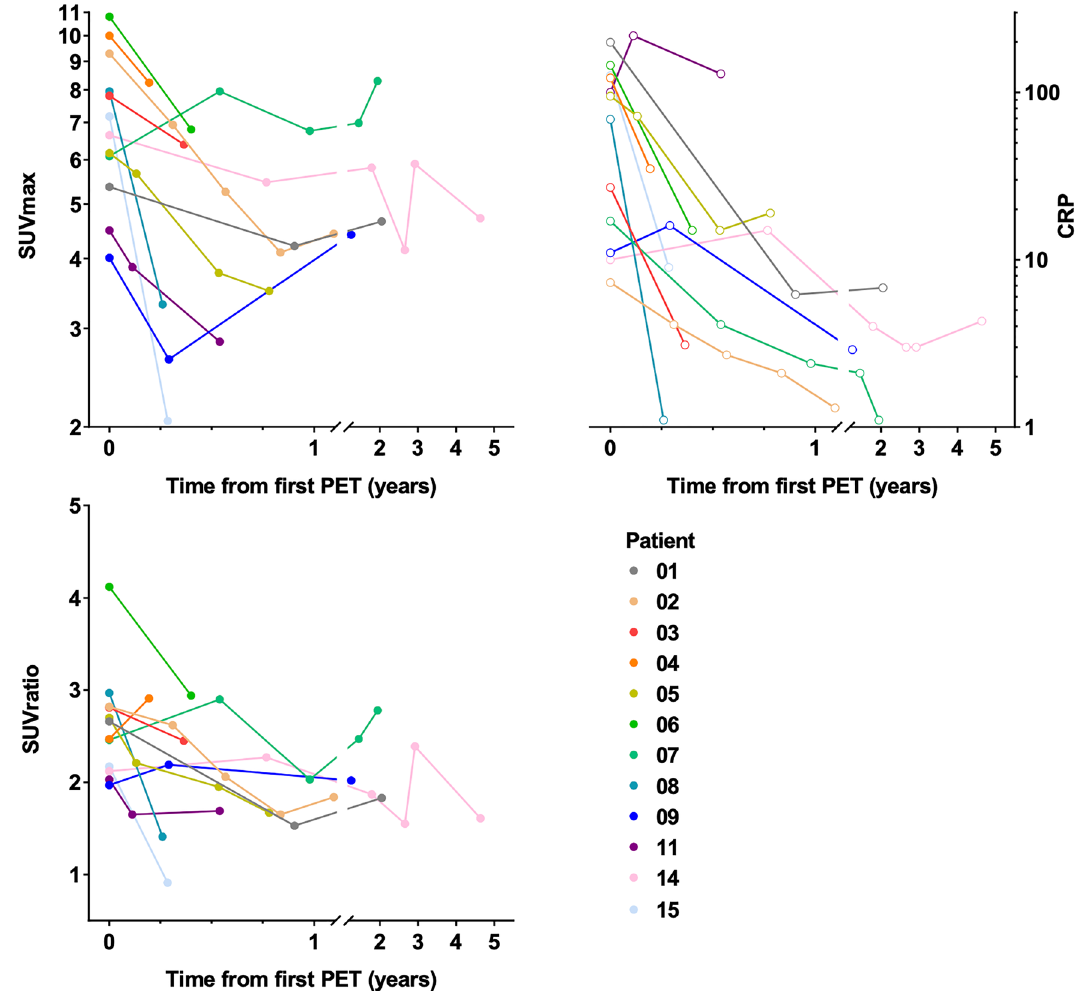
Figure 1. Courses over time of metabolic activity in PET/CT (SUVmax and SUVratio in the two graphs on the left) and CRP (graph on the right) in patients with proven infective native aortic aneurysms. Note : PET/CT provides additional or altering information (as defined in the methods section) on the course of disease in at least 14 comparisons (56%) in 11 patients (73%), as compared to CRP alone (i.e. patients: 02, 03, 04, 05, 06, 07, 08, 09, 11, 14, 15). Abbreviations: PET: positron emission tomography; SUV: standardized uptake value; CRP: C-reactive Thus, the final patient population consisted of 15 patients. All patients were eventually treated with open and/or endovascular repair (six prior to the first PET/CT, seven prior to the second, and two prior to the third PET/CT) (Table 1). At the time of the initial PET/CT examination, patients had a median age of 61 years (IQR 54–85), one patient (7%) was female, six (40%) were smokers or had a history of smoking, two (13%) patients were diabetic, and six (40%) had renal insufficiency. The diagnoses of INAA were confirmed by blood culture (n = 11; 73%), culture or PCR from tissue obtained during surgical revision (n = 2; 13%) and serology (n = 2, 13%) (Table 2). PET/CT examinations. We performed a total of 53 PET/CT scans in 15 patients (Figs. 1, 2, 3, Table 3) after intravenous injection of a median of 353 Megabecquerel of FDG (IQR 334—400). Initial imaging was per- formed for nine (60%) patients before and for six (40%) patients after vascular intervention, 11 (73%) received antimicrobial therapy at the time of initial imaging. The median visual 4-point grading score was 4 (11 × score 4, 3 × score 3, 1 × score 2). Eventually, all patients underwent vascular intervention with graft placement, and were treated with antibiotics (Tables 1 and 2). All aneurysms (or grafts) had increased focal FDG uptake on the initial PET/CT examination (SUVmax 6.8 (IQR 5.7–21.8); SUVmax aneurysm/graft to blood pool background ratio 2.7 (IQR 2.2–7.3)). FDG uptake in all aneurysms/grafts (100%) was higher than liver background (SUVmax 3.4 (IQR 2.7–6.1) (Figs. 1, 2, 3, Table 3). The first follow-up PET/CT (112 (IQR 95–721) days after the first PET/CT) was performed in all patients, and 13 (87%) patients received antimicrobial therapy at the time (in one patient antimicrobial therapy was started after the second PET/CT in another therapy was already terminated). The median visual 4-point grading score